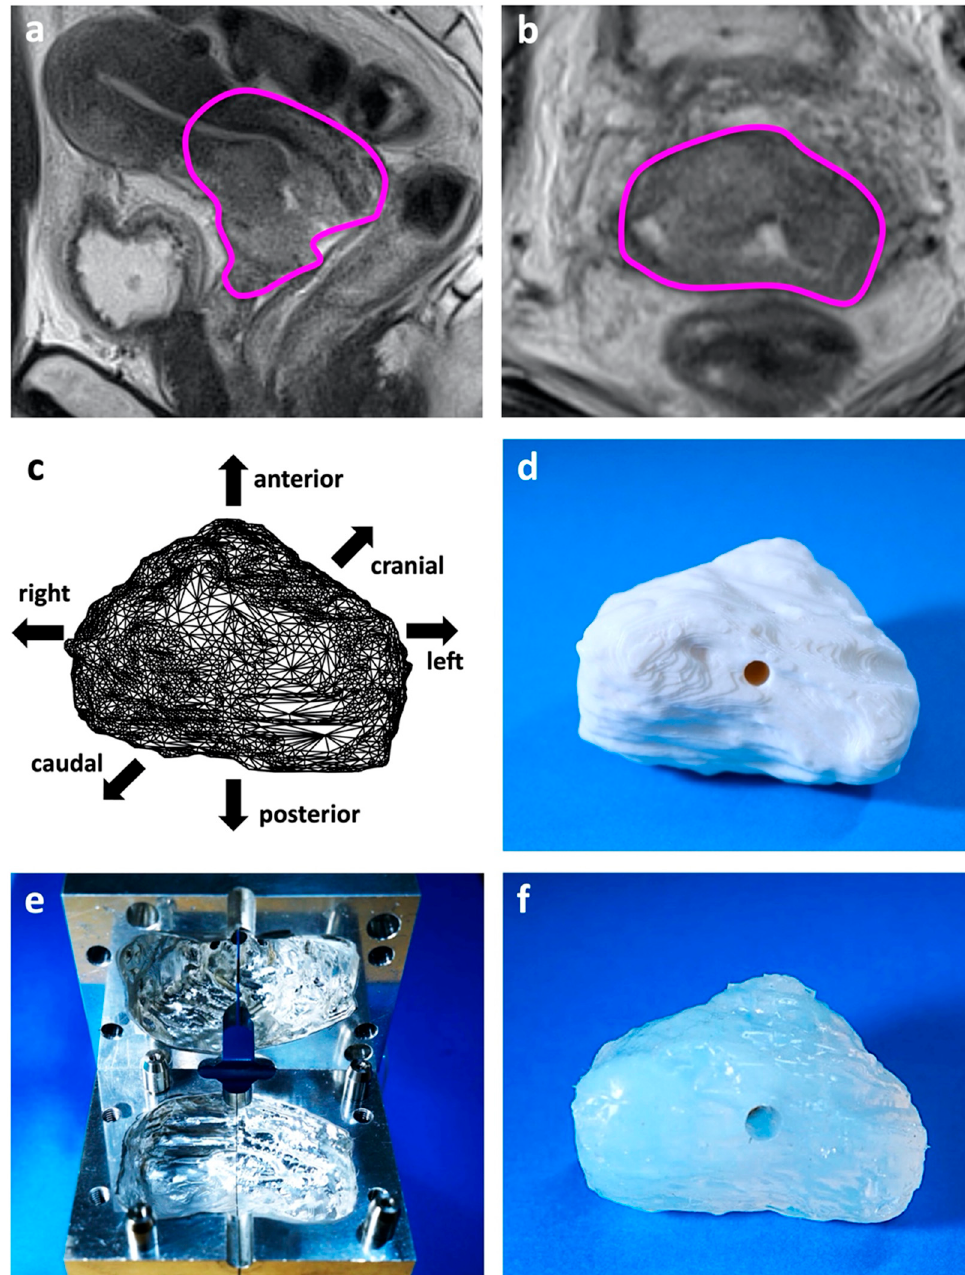
Figure 1. Production of the patient-derived tumor phantom using 3D printing: ( a ) T2-weighted MRI of the model patient obtained at the first brachytherapy session. HR-CTV is delineated in magenta in the sagittal plane and ( b ) axial plane. ( c ) HR-CTV data in computer-aided design software. ( d ) HR-CTV model printed in ABS plastic using a 3D printer. ( e ) Aluminum mold created against the ABS plastic HR-CTV model. ( f ) Translucent soft silicon HR-CTV model created from the aluminum mold.